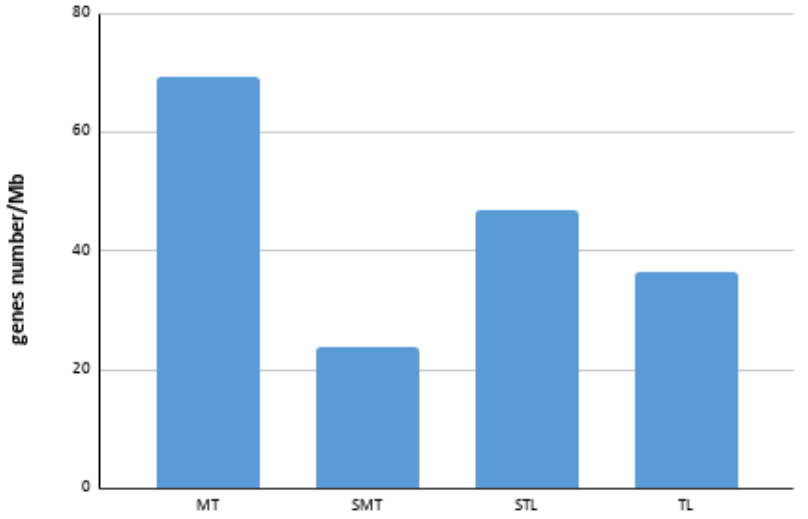
Figure 4. Bar chart of average gene density in each chromosome type. MT: metacentric; SMT: submetacentric; STL: subtelocentric; TL: telocentric. submetacentric; STL: subtelocentric; TL: telocentric. Some BAC clones overlapped, evidencing co-location (Table S1). Thus, BAC clones